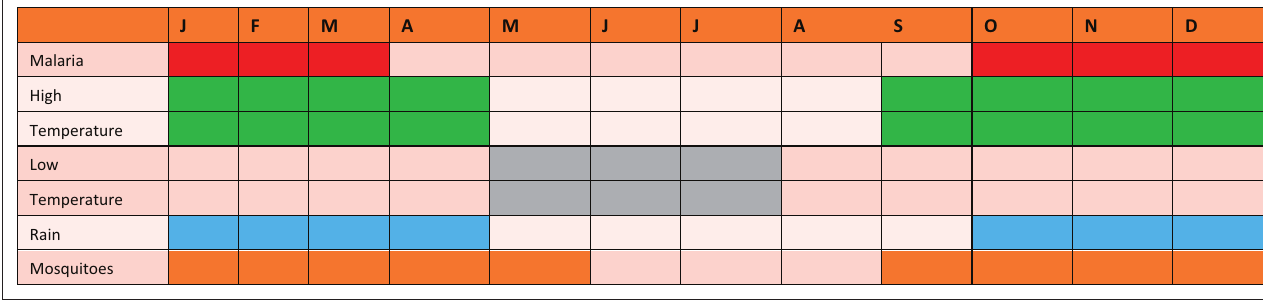
FIGURE 5: Community Disease Calendar from the Participatory rural appraisals.